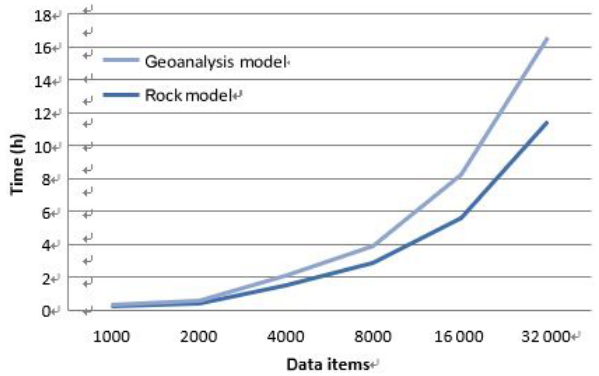
Figure 9. Space usages of the two data models with increasing amount of data